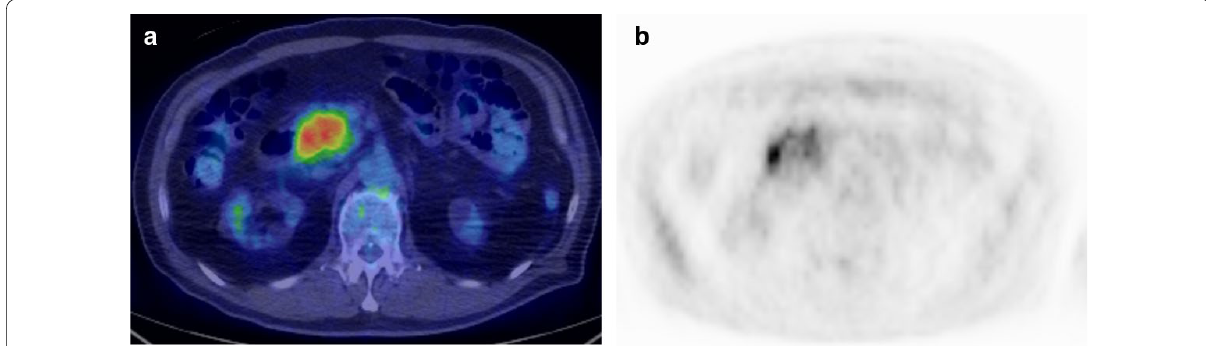
Fig. 2 PET/CT. a PET/CT showed positive accumulation of SUVmax 6.02 at the lesion site; b the highest accumulation of about SUV 6.0 was observed near the duodenal side of the mass, and the lowest one at about SUV 3.0 was observed on the opposite side